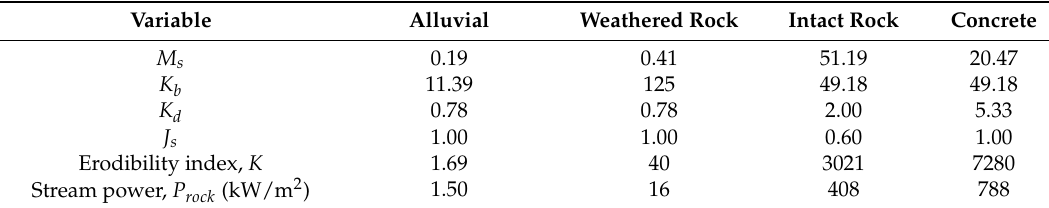
Table 6. Values of the parameters to estimate the Erodibility Index ( K ) and then the Power Threshold ( P rock ) for bed layers (water cushion depth D s = 24 m).